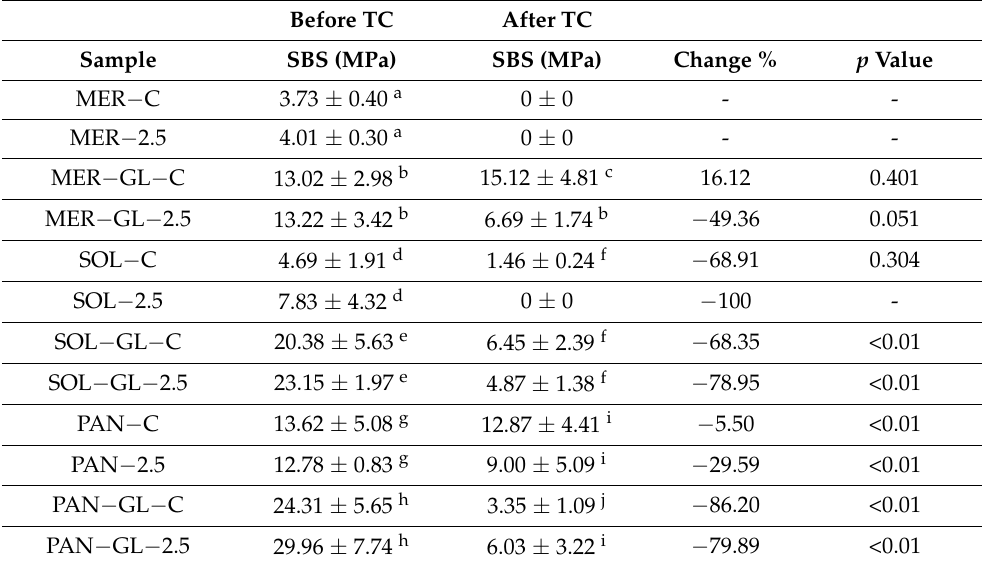
Table 2. Results of the shear bond strength tests for all composite cements studied. Before TC After